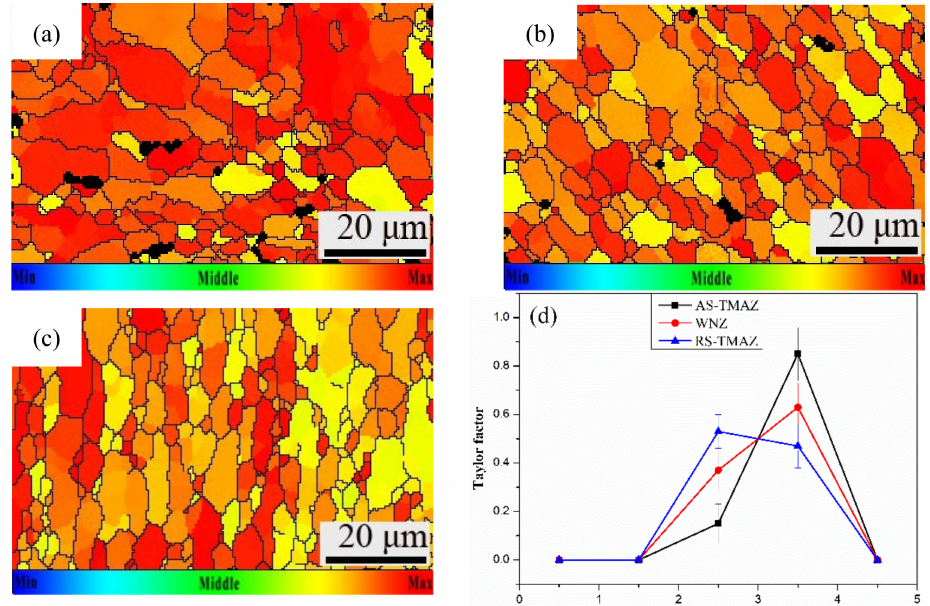
Figure 6. Taylor factor maps: ( a ) AS-HAZ; ( b ) SZ; ( c ) RS-TMAZ; ( d ) Value of Taylor factor of 7A52 aluminum alloy FSW